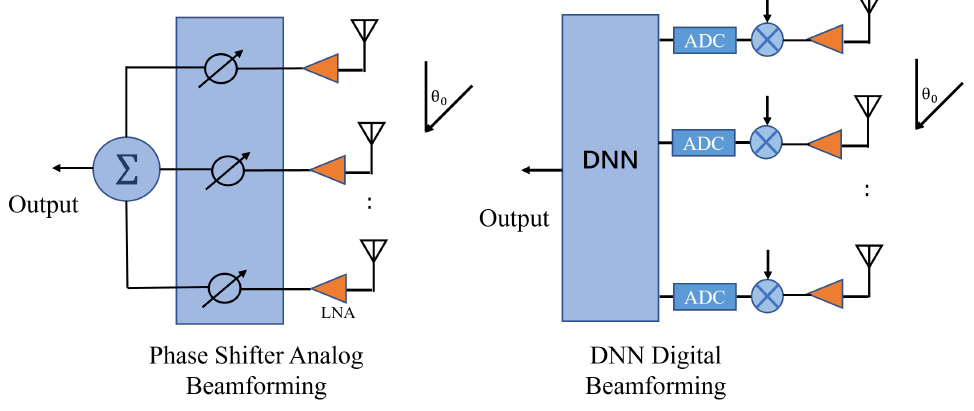
Figure 1. Schematic of Phase shift and DNN